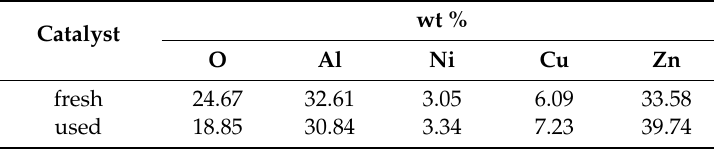
Table 2. Quantitative EDS analysis of Cu–Zn/ γ –Al 2 O 3 catalysts.